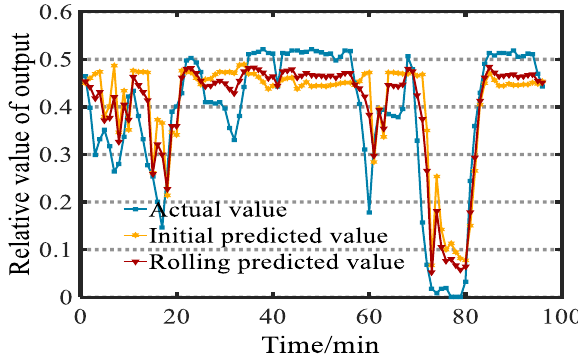
Figure 4. Comparison of wind power prediction results.